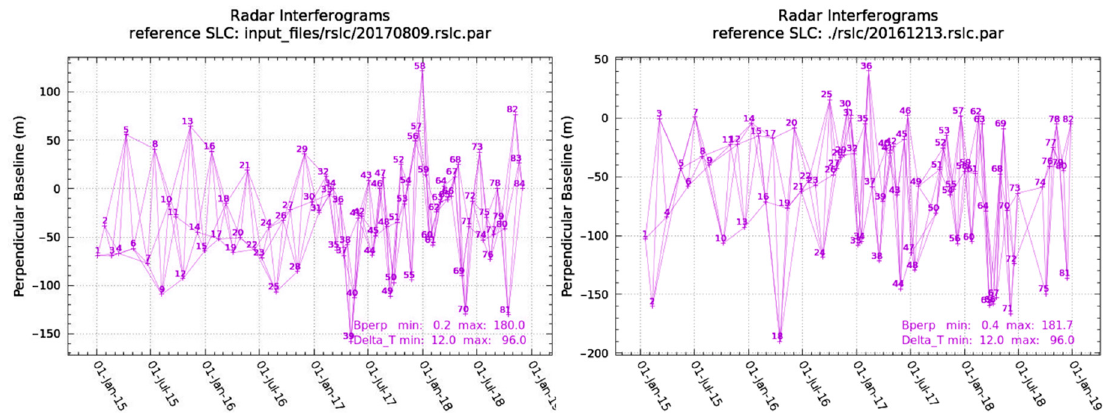
Figure 3. Baseline vs. time plots ( left ) ascending orbit data ( right ) descending orbit data.